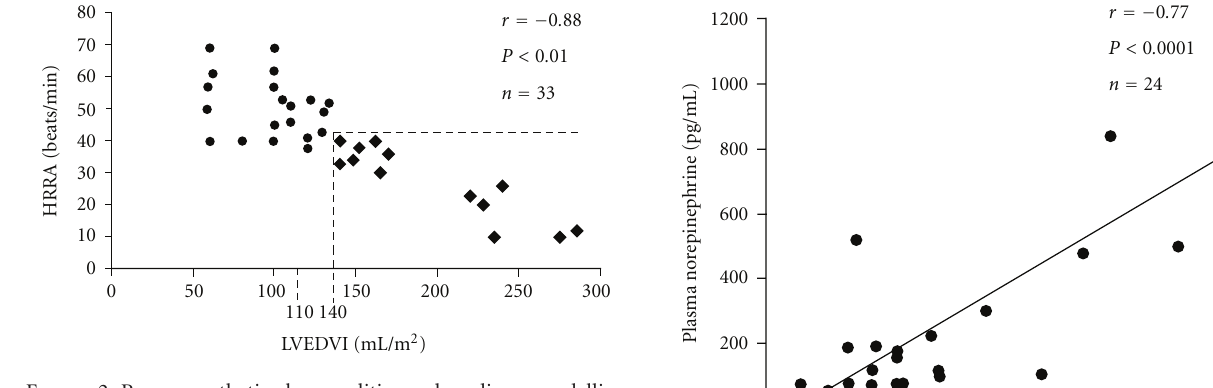
Figure 2: Parasympathetic abnormalities and cardiac remodelling in chagas disease; the heart rate response to atropine (HRRA) is indirectly related to left ventricular end-diastolic volume (LVEDI). Thus, parasympathetic impairment is secondary to cardiac remod- elling and dysfunction ( • = patients with segmental myocardial dys- function, normal HRRA, and no ventricular dilatation; (cid:2) = patients with abnormal HRRA and progressive ventricular dilatation). (see [22], adapted with permission form Elsevier).